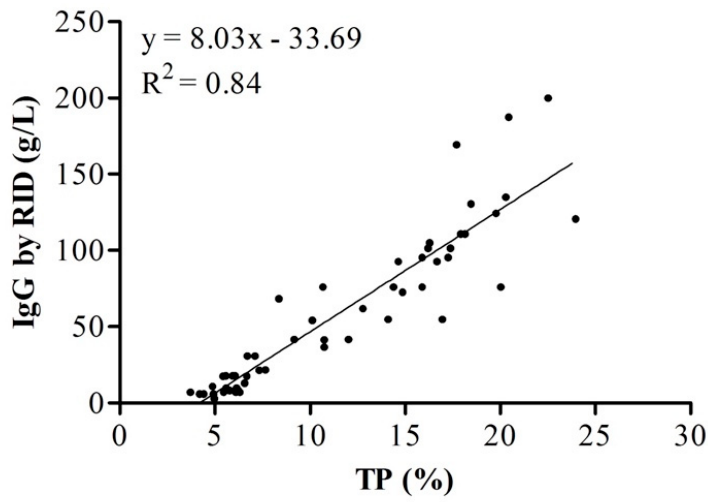
Figure 2. Relationship between total protein (TP) and immunoglobulin G (IgG) in bovine colostrum. IgG was measured by radial immunodiffusion, and total protein was measured by MilkoScan FT + .